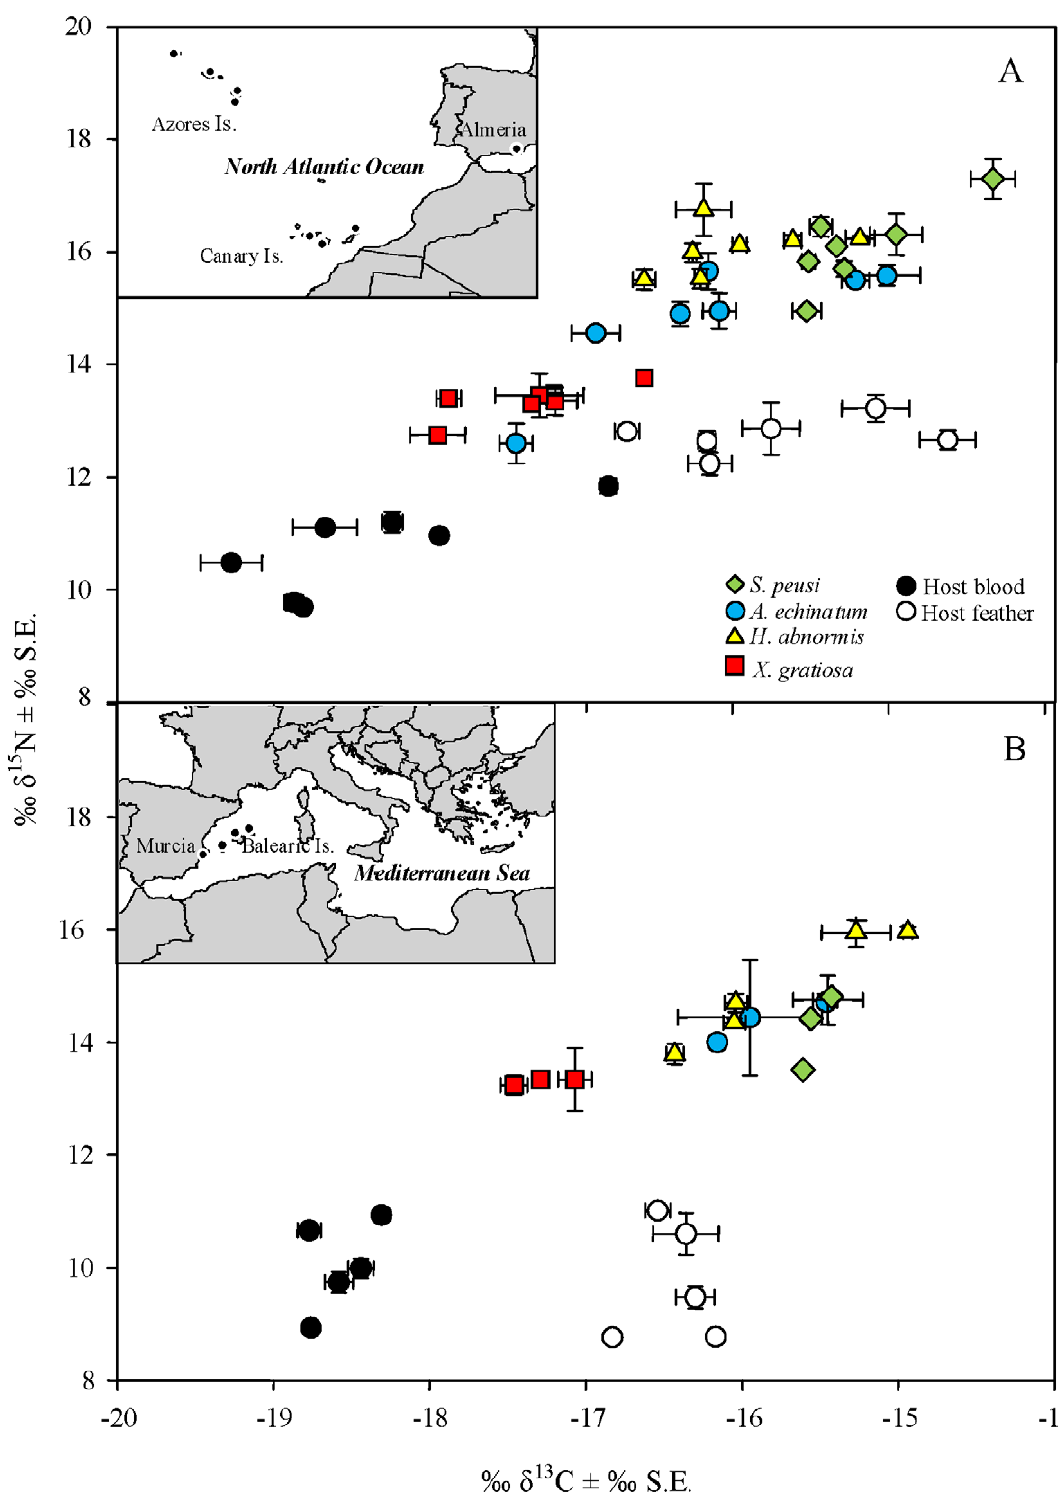
Figure 1. Isotopic composition of host and ectoparasite tissues across the study area. Geographic variation in mean d 15 N and d 13 C ( 6 Standard Error) values of host tissue and ectoparasite species from 12 Atlantic (A) and Mediterranean (B) Calonectris breeding colonies. doi:10.1371/journal.pone.0010454.g001 the analysis to three colonies (St.Maria, Eivissa and Lanzarote), ectoparasite isotope signatures co-vary relative to that of the host which cover most part of the breeding range of the host species we examined isotopic similarity in ectoparasites and in host tissues and had the greatest sample size. Then, to examine whether (blood and feathers) across all breeding locations. First, we